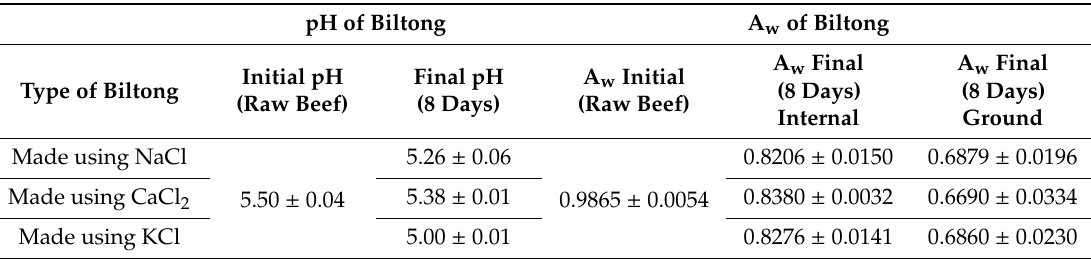
Table 1. Initial and final pH and water activity (a w ) of biltong beef (before processing and after 8 days of drying) made with NaCl, KCl, or CaCl 2 . All analyses were performed on a triplicate series of